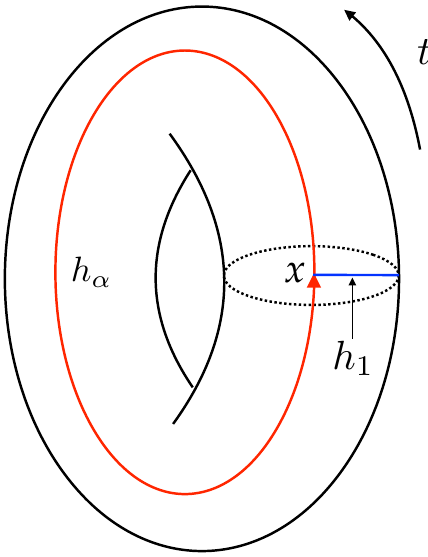
Figure 1 . Bulk dual of the torus one-point block. The blue line represents the bulk-to-boundary propagator for h 1 , and the red line the propagator for the (cid:11) particle to propagate once around the thermal